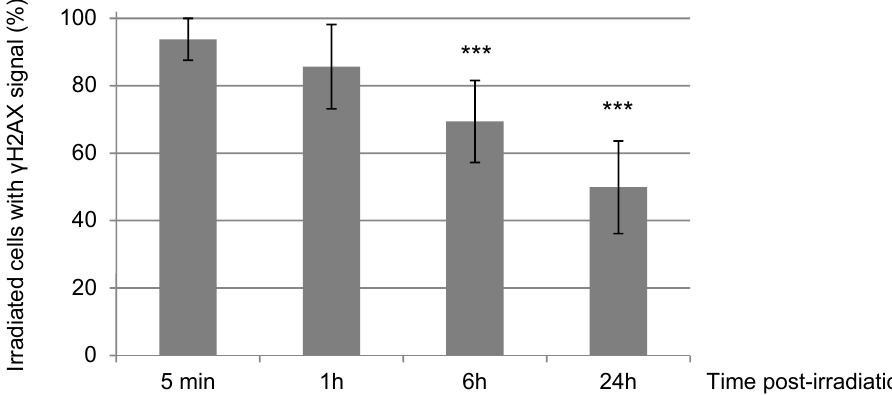
Figure 3. Percentage of γ H2AX-positive NIH-3T3 cells upon irradiation with α -particles. We quanti- fied the number of NIH-3T3 cells from samples used previously in Figure 2 carrying γ H2AX signal among the total irradiated cells at the indicated times after α -particle irradiation. Each value shown represents the mean of at least three independent irradiations. The error bars represent the standard error, and the p values are indicated (*** p <